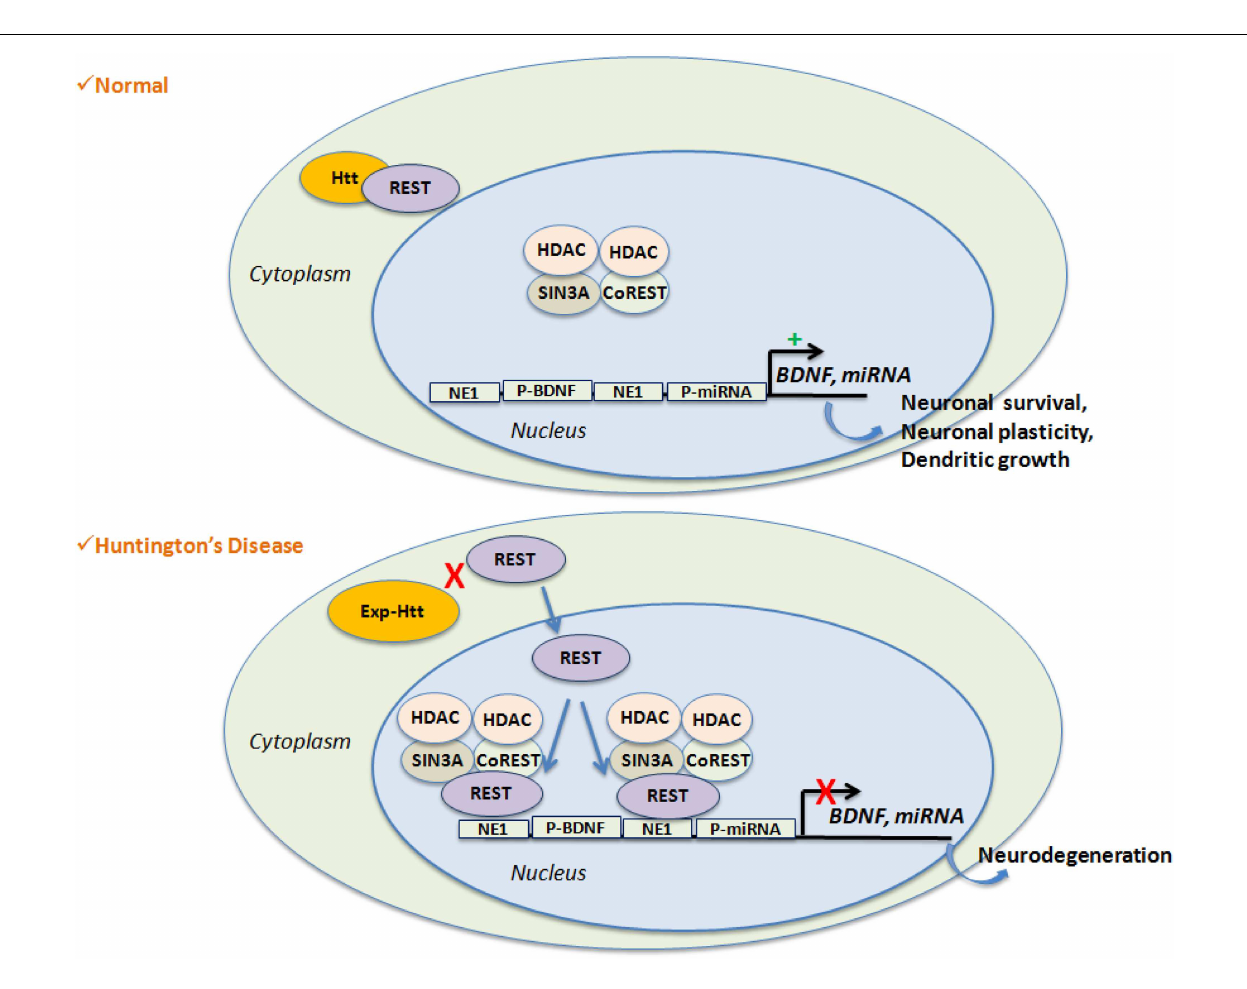
dendrites growth. Expansion of Htt disrupts its binding with REST and facilitates nuclear entry of REST along with the formation of the repressor complex on the RE1 site. Activation of RE1 site results on target gene silencing and participates to